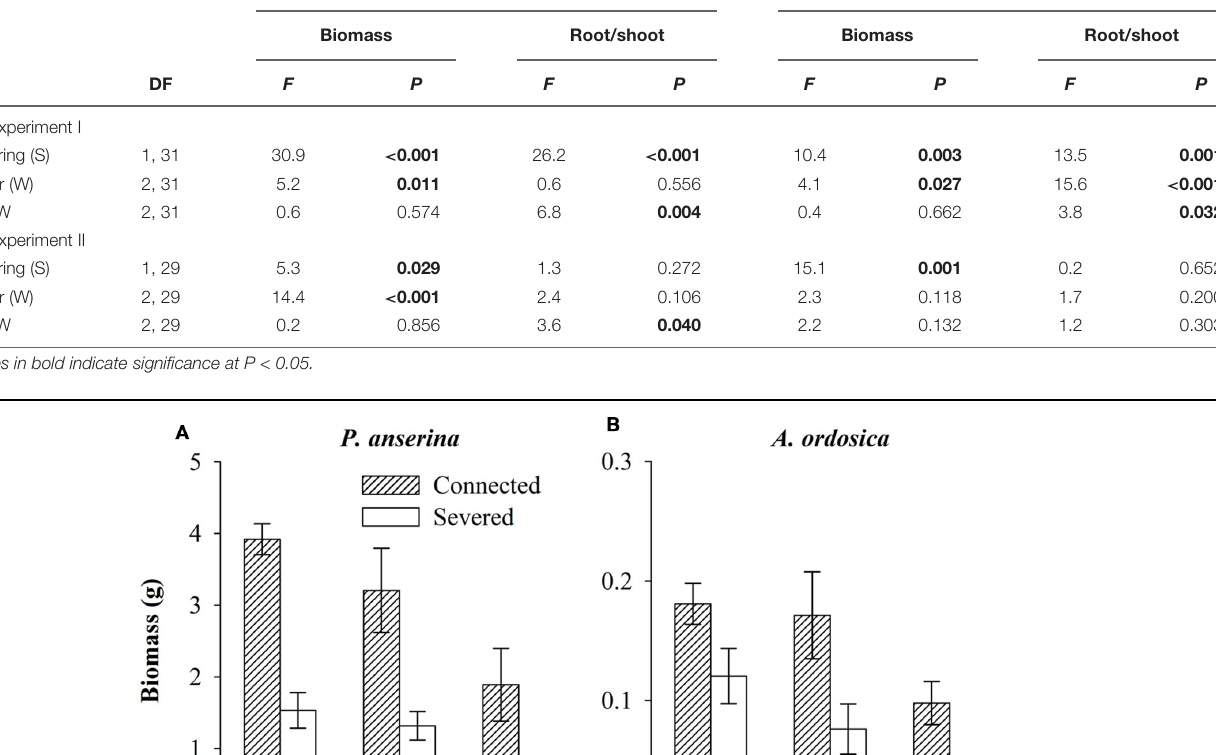
TABLE 1 | Effects of severing stolons and water treatment on biomass and shoot to root ratio of Potentilla anserina and Artemisia ordosica in (A) Experiment I and (B) Experiment II. Effect